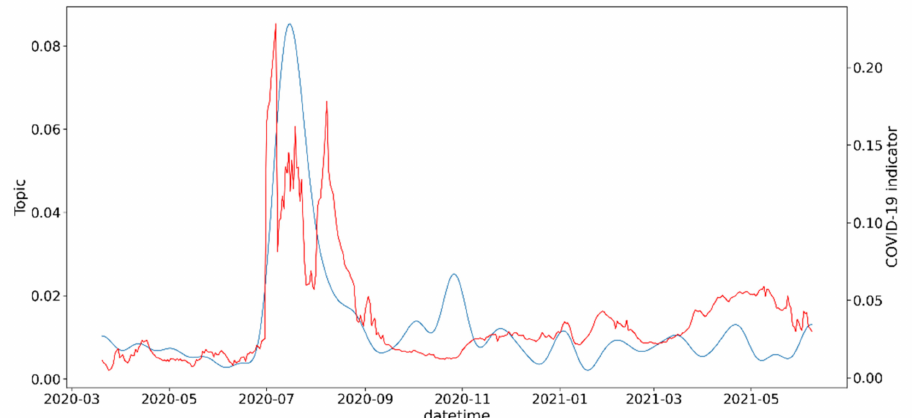
Figure A5. COVID-19 indicator—Positive rate. Topic—Medication, Medication, Drug, Medication, Medication_medication, Medical, Pharmacy.